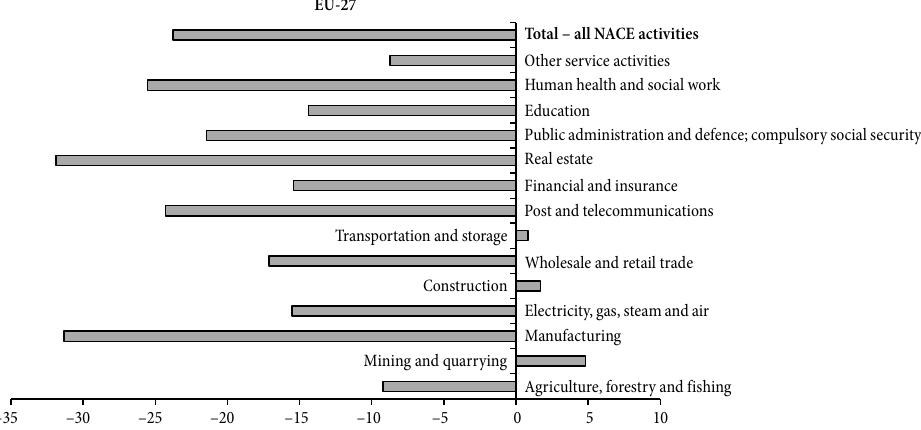
Fig. 5. Average of technological contribution expressed as percentage during 2000–2012 in the EU-27 member